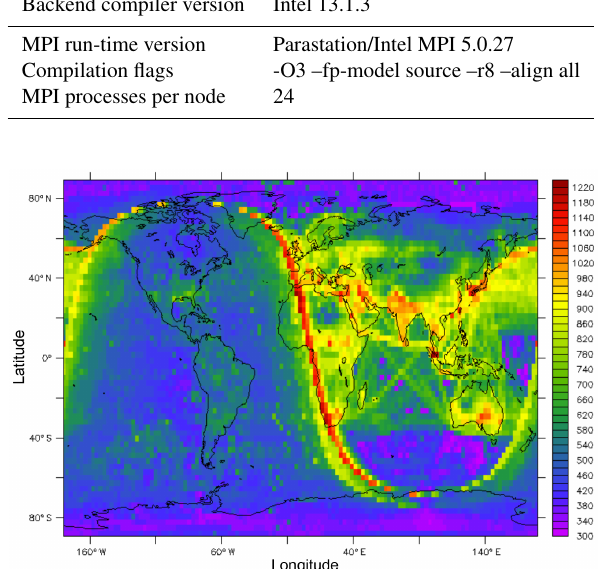
Figure 4. Column-maximum MECCA kernel execution wall time in microseconds for a single time step. The adaptive time-step inte- grator shows a non-uniform run time caused by stratospheric pho- tochemistry and natural and anthropogenic emissions.